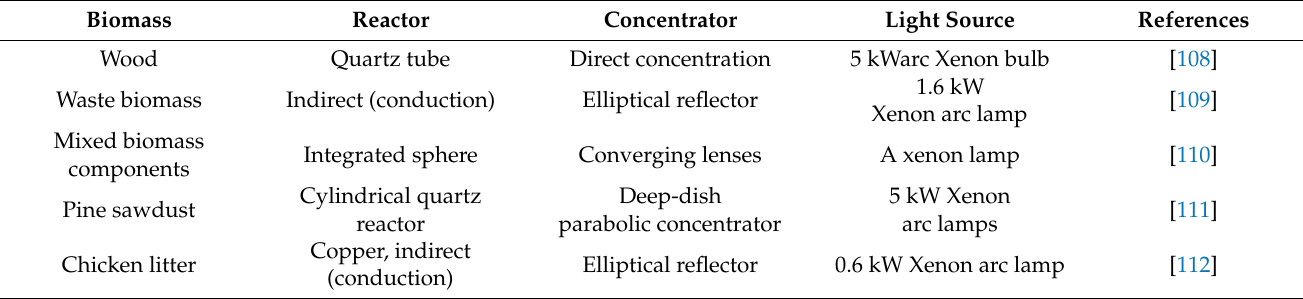
Table 6. Summary of solar-simulated biomass